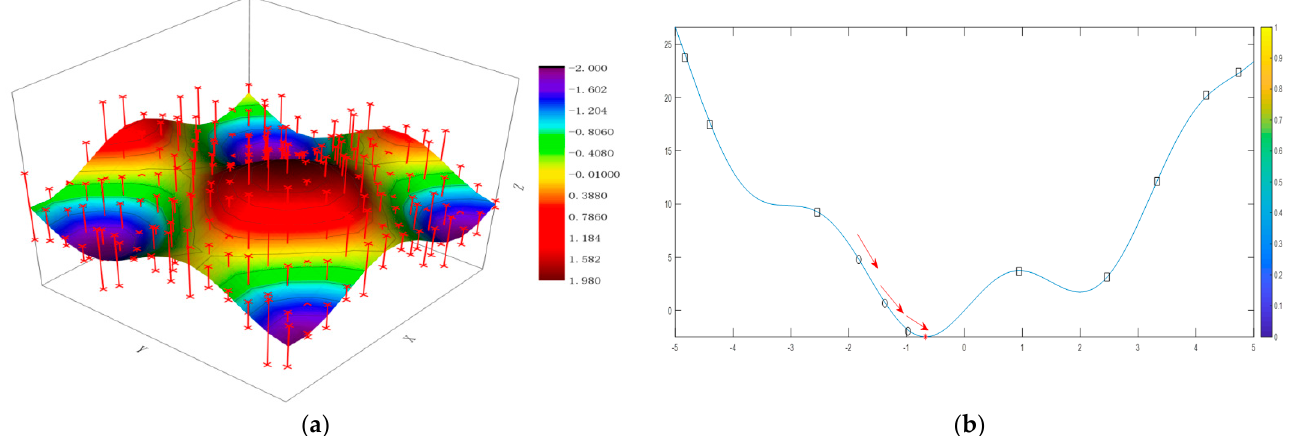
Figure 3. Using genetic algorithm combined with gradient descent method to find the optimal solution. ( a ) is the initialization of the population and the Red Cross represents the initial population, and ( b ) looks for the lowest loss function, the rectangles represent the initial population, the circles represent the changes in the population under the rule of gradient descent, and the red arrow represents the path the algorithm takes to find the optimal solution.